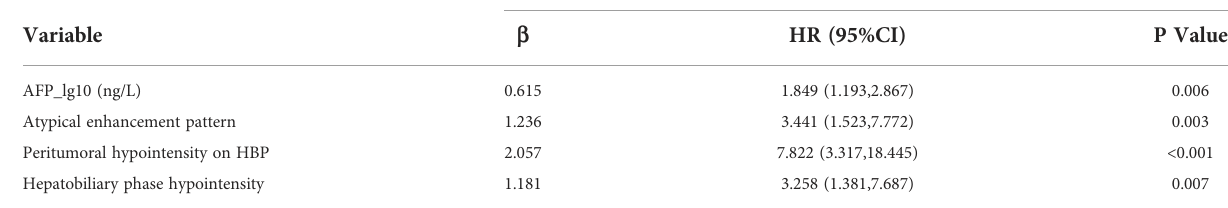
TABLE 3 Multivariate analysis factors predictive of